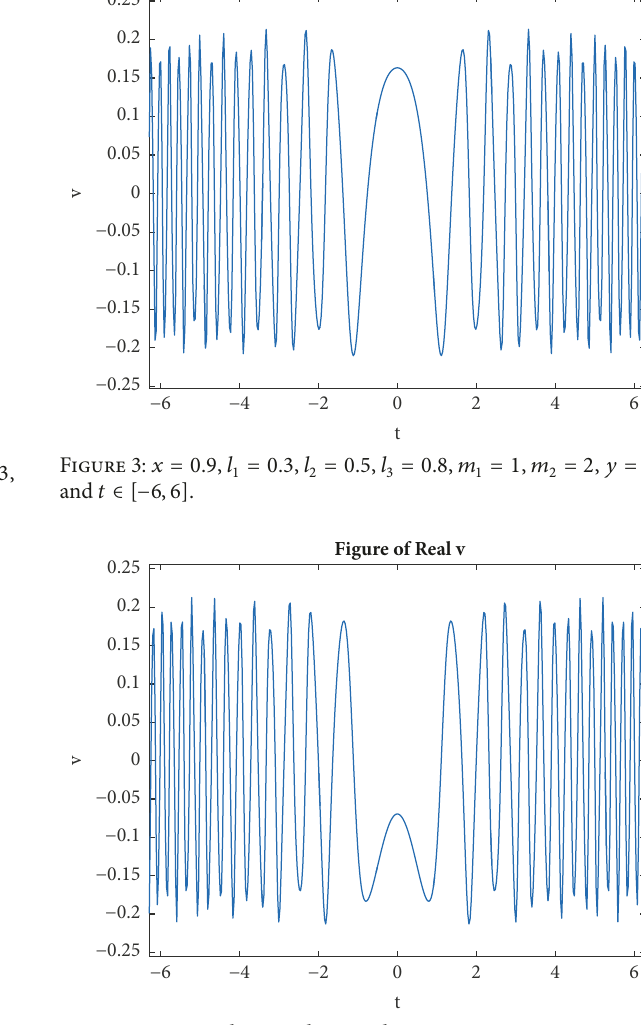
Figure 4: 𝑥 = 0.9 , 𝑙 1 = 0.3 , 𝑙 2 = 0.5 , 𝑙 3 = 0.8 , 𝑚 1 = 1 , 𝑚 2 = 2 , 𝑦 = 3 , and 𝑡 ∈ [−6,6] .